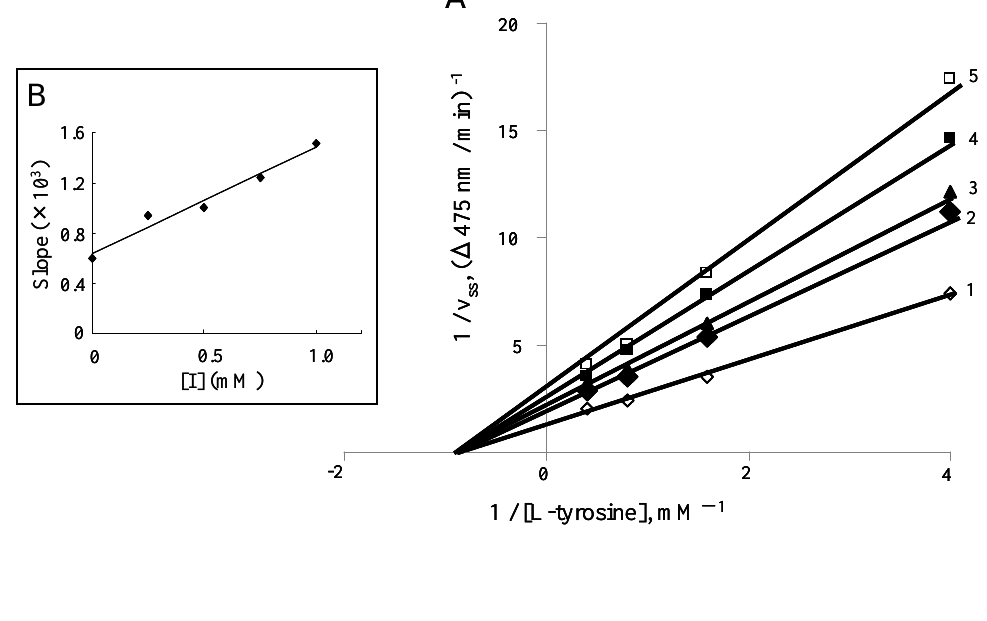
Figure 6. Determination of inhibitory type and inhibition constants of indomethacin on monophenolase activity of mushroom tyrosinase. ( A ) Lineweaver-Burk plots for inhibition of indomethacin on monophenolase activity. The concentrations of indomethacin for curves 1–5 were 0 mM, 0.25 mM, 0.5 mM, 0.75 mM and 1.0 mM, respectively; ( B ) The plots of slope versus the concentration of